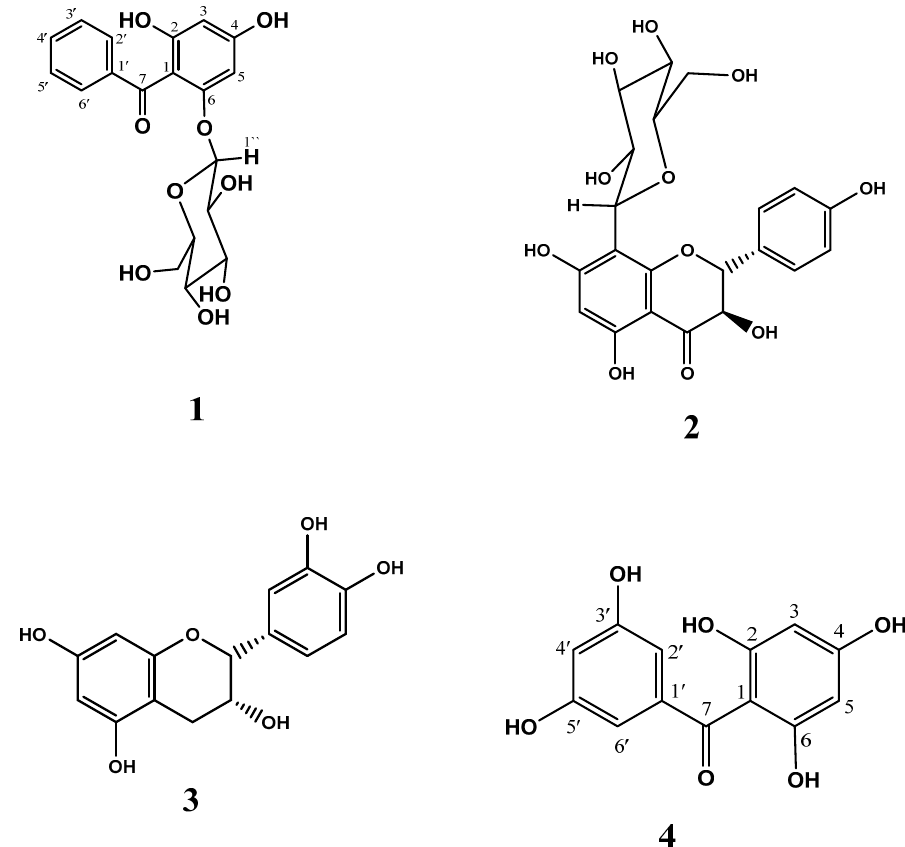
Figure 3. Chemical structures of compounds 1 – 4 isolated from Garcinia mangostana .